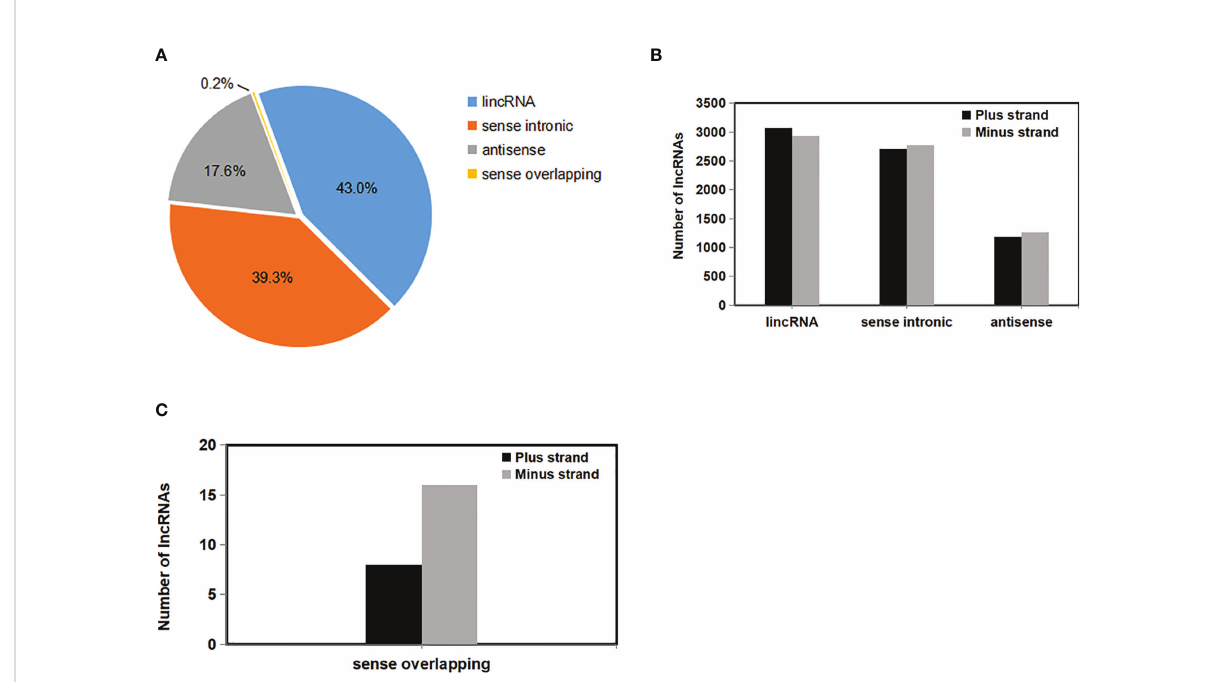
FIGURE 4 Annotation classi fi cation of 13,957 rose lncRNAs. (A) Classi fi cation of rose lncRNAs according to their genomic position and overlap with protein-coding genes. (B) Numbers of lncRNAs in the Watson or Crick strand for each of the three main classes were labelled on the columns (intergenic, intragenic, and antisense lncRNAs). (C) Number of lncRNAs in the Watson or Crick strand for sense overlapping class was labelled on the columns. The proportion of the four kinds of lncRNAs was